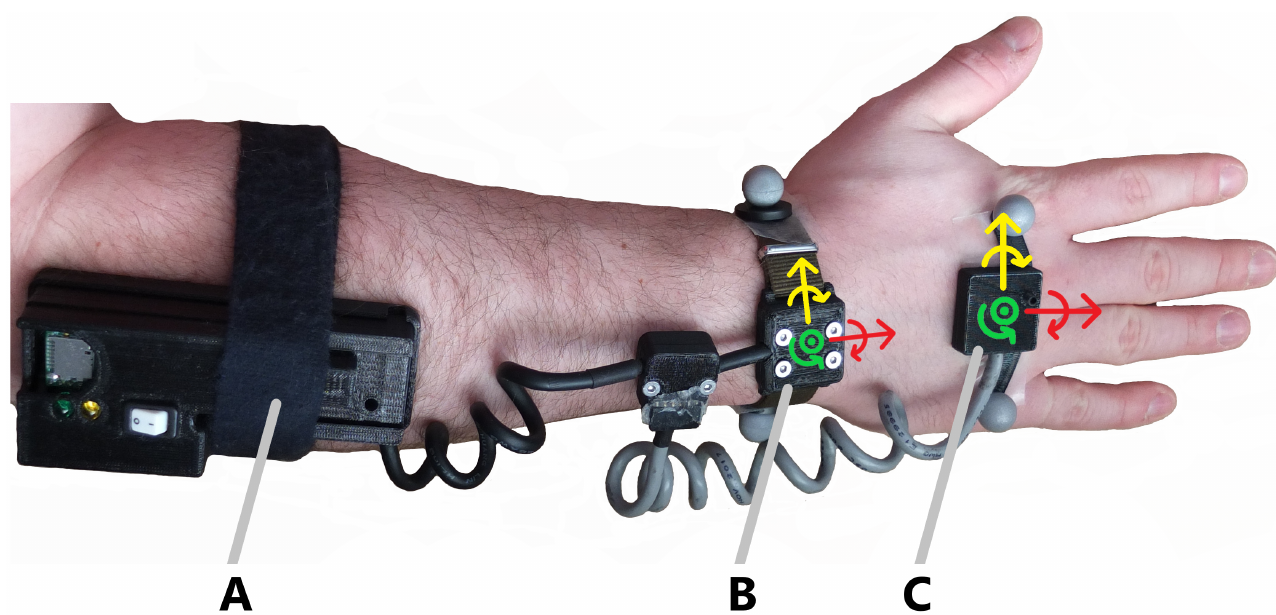
Figure 1. Wearable device showing Datalogger (A), wrist IMU (B), and hand IMU (C). Positive directions for the local sensor coordinate systems are approximately aligned with distal (red) radial (yellow) and dorsal (green)